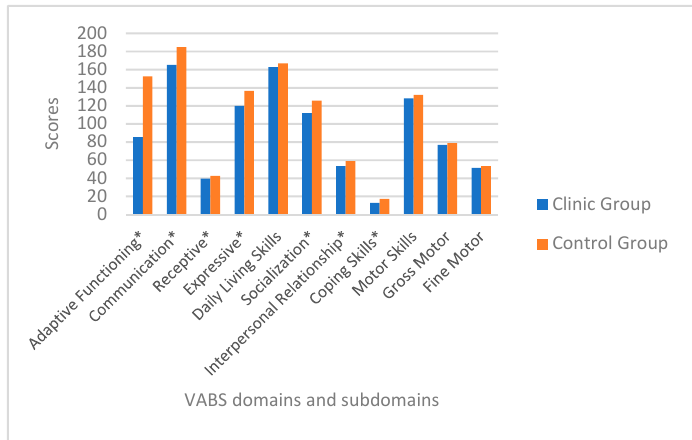
Figure 1. VABS adaptive functioning domain scores comparing: ( a ) Children with leukemia one-year post-diagnosis and controls, ( b ) VABS adaptive functioning sub-domain scores comparing children with leukemia one-year post-diagnosis and healthy peers. * = statistically significant domain and subdomains.